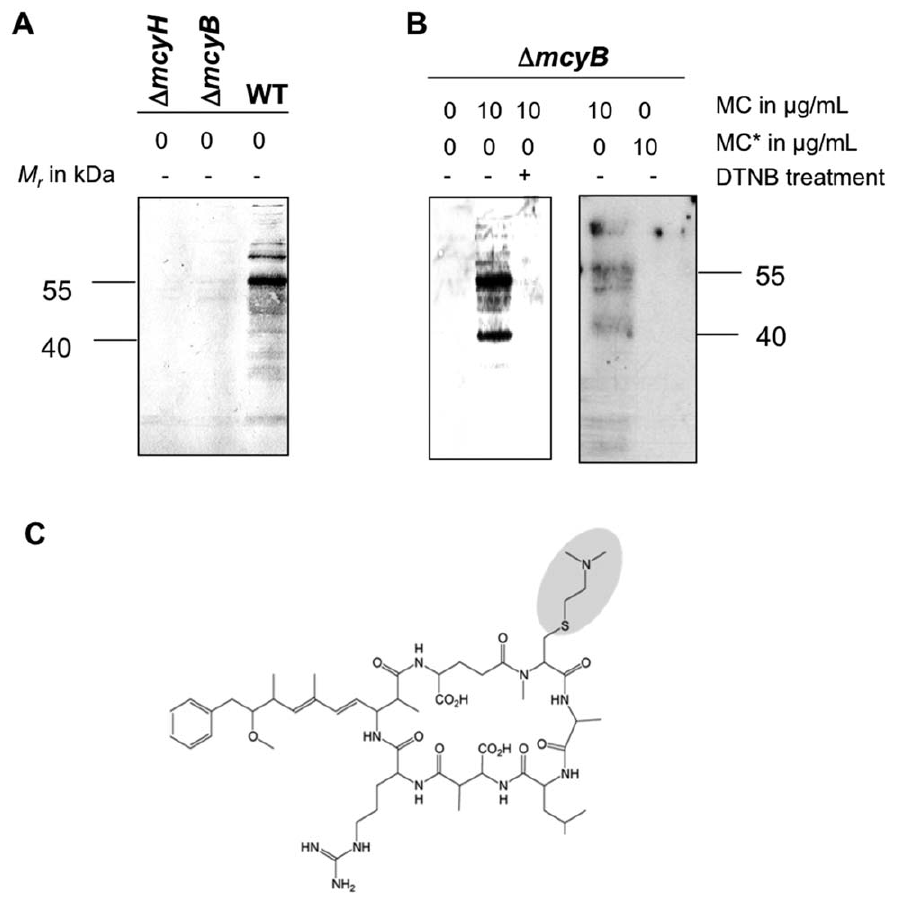
Figure 2. Immunoblot analyses of soluble Microcystis protein extracts using a microcystin-specific antibody. A) Protein extracts of the D mcyH , D mcyB mutants and wild type. B) Protein extracts of D mcyB mutant prior and after addition of microcystin-LR and DTNB pre-treatment (left). Protein extracts of D mcyB mutant with addition of microcystin-LR or cysteamin-linked microcystin-LR MC* (right). C) Modified microcystin variant with a cysteamin group attached to the N-methyldehydroalanine moiety.